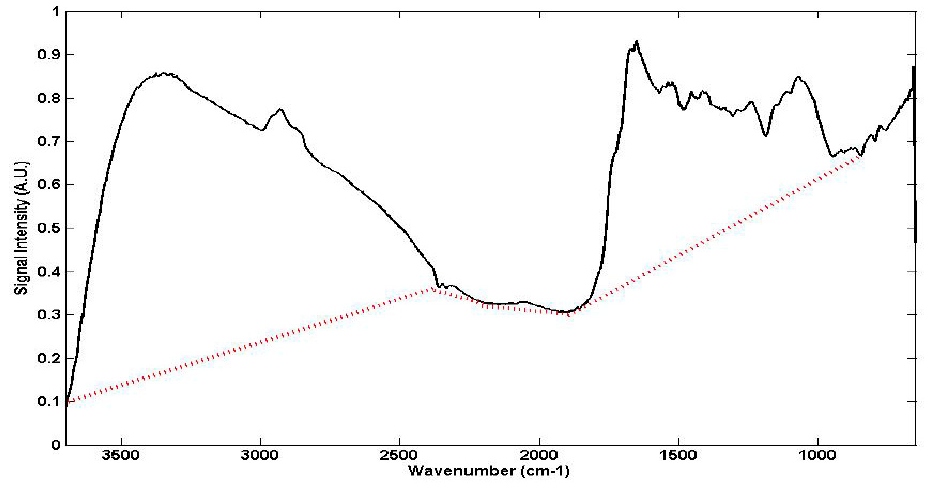
Figure 3. Example of the selection point method application for a spectrum to draw line curves.